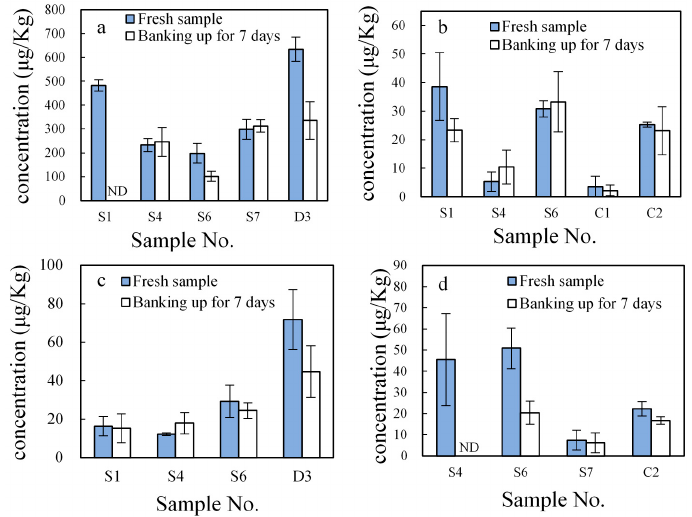
Figure 4. Concentrations of E3 ( a ), 17 β -E2 ( b ), BPA ( c ), and EE2 ( d ) in fresh manure and manure that has been banked up for seven days. S1, S4, S6, S7, C1, C2 and D3 represent farm numbers; ND, means under detection limit.